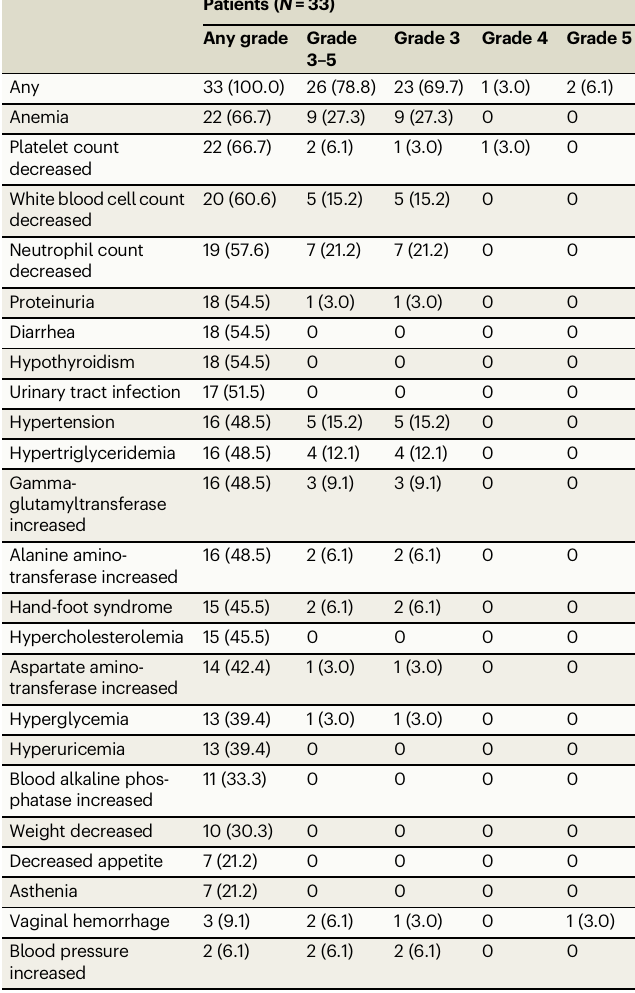
Table 3 | Treatment-related adverse events Patients ( N